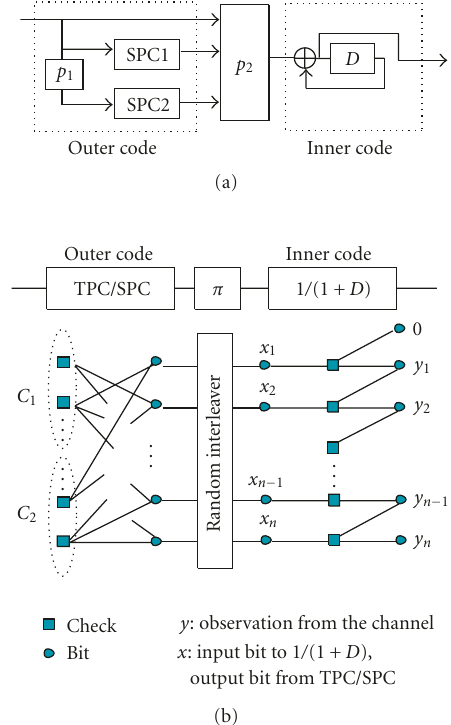
Figure 1: PA codes (a), code structure (b). Graph